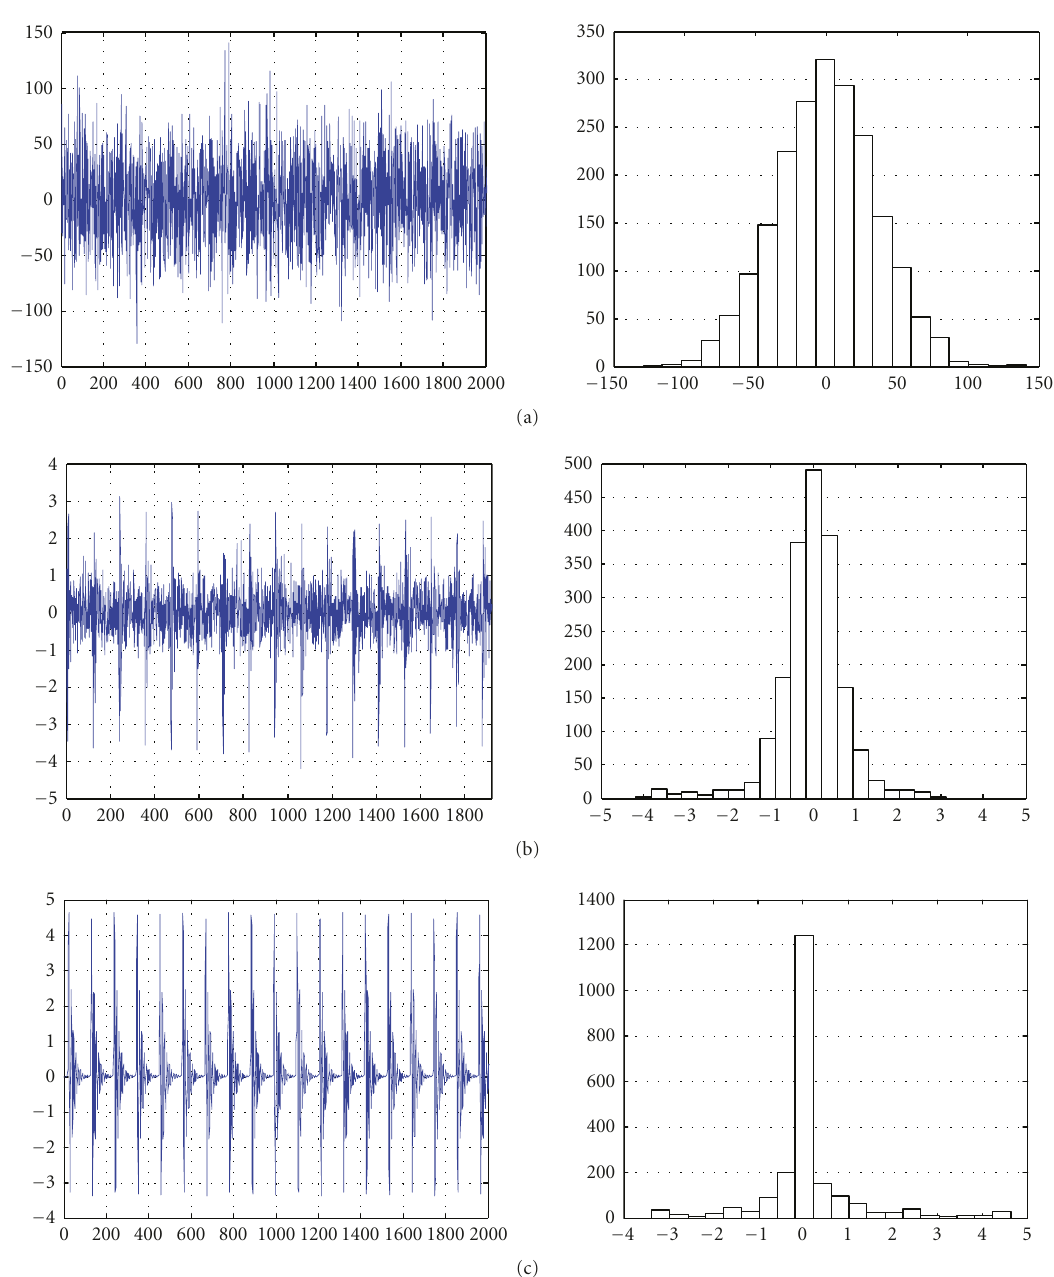
Figure 4: (a) The noise signal (kurtosis = 3 . 0843), (b) the overall vibration signal (kurtosis = 7 . 7644), and (c) outer-race fault impulses (kurtosis = 8 . 5312) with the corresponding intensity distribution